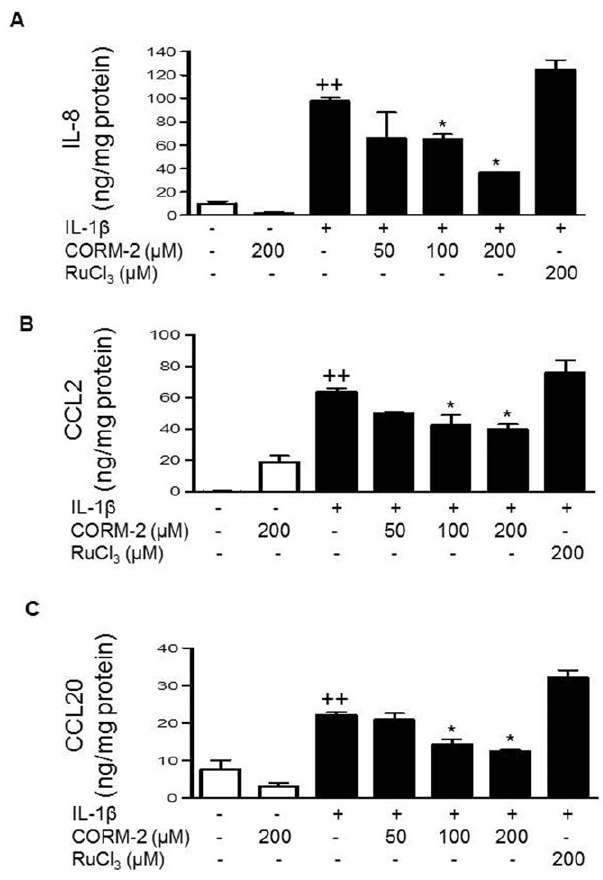
Figure 3. Effect of CORM-2 on the levels of chemokines released into the medium by OA synoviocytes. (A) IL-8, (B) CCL2 and (C) CCL20 protein levels. Cells were stimulated with IL-1 b (10 ng/ml) for 24 h in the presence or absence of CORM-2 (50, 100, 200 m M) or RuCl 3 (200 m M). Protein levels were determined in cell supernatants by ELISA. Data are expressed as mean 6 S.E.M. Duplicate samples from 6 patients were used. ++ P , 0.01 with respect to nonstimulated cells. * P , 0.05 with respect to IL-1 b .